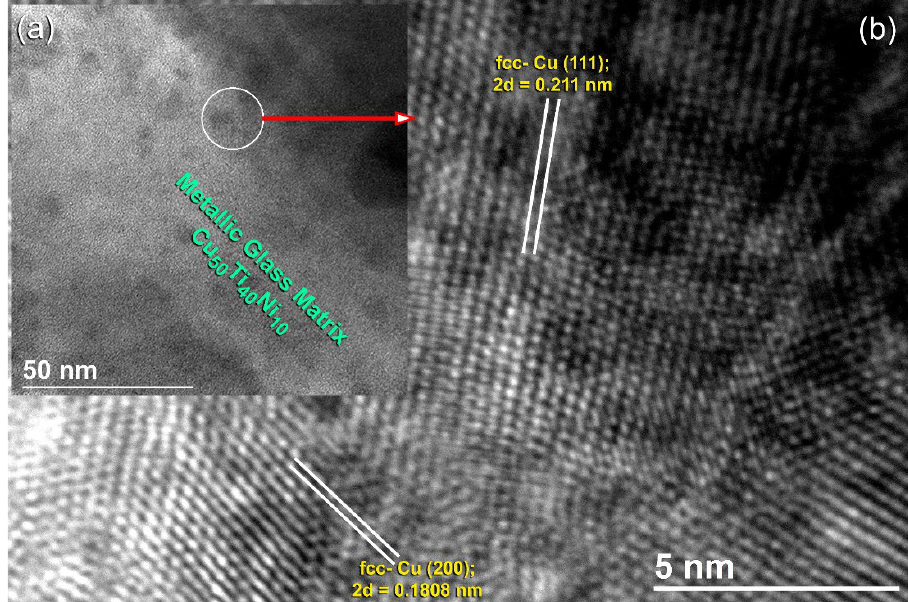
Figure 14. ( a ) Bright-field image (BFI) of Cu 50 Ti 40 Ni 10 powders after cold spray coating onto SUS304 substrate at 540 °C. The corresponding atomic-resolution TEM image of the circular zone shown indexed in ( a ) is displayed in ( b ).